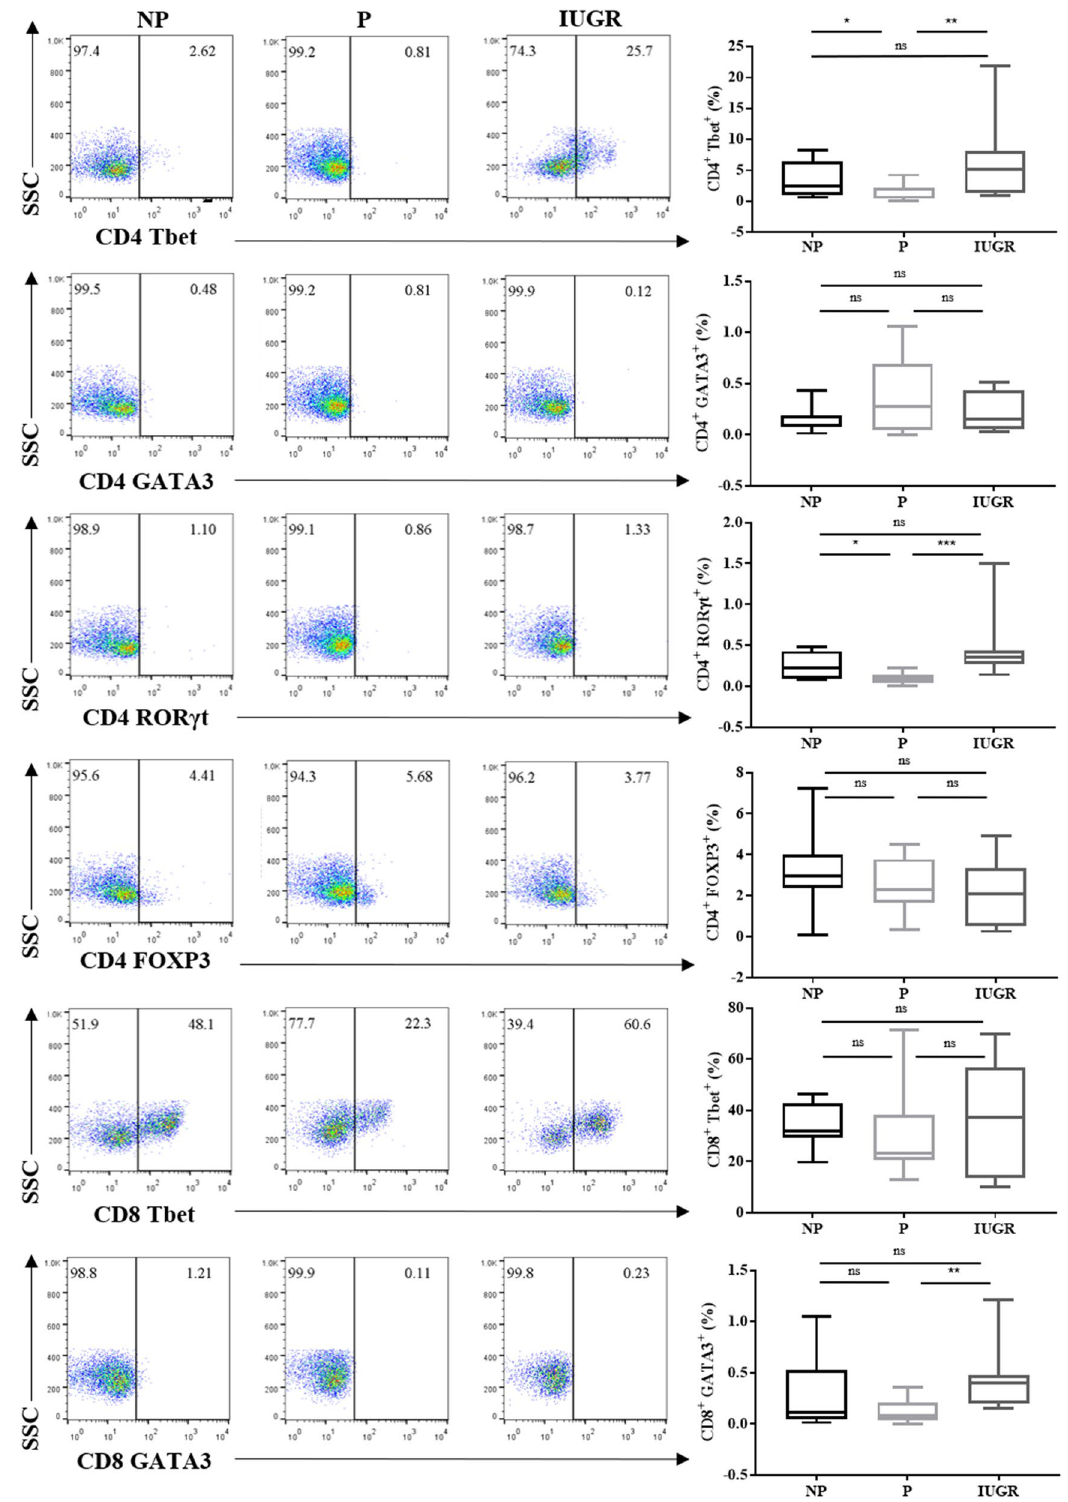
Figure 2. Tbet and RORγt is decreased in CD4 + T-cells during normal pregnancy compared IUGR. Representative flow cytometry dot plots of transcription factor expression in CD4 + Tbet (Th1), GATA3 (Th2), RORγt (Th17), FOXP3 (Treg) and CD8 + Tbet (Tc1), and CD8 + GATA3 (Tc2) T-cells from NP (n = 12), P (n = 12) and IUGR (n = 8). Box and whisker plots indicate median and IQR of T-cells expressing transcription factors. * p < 0.05, p ** < 0.01, ns = non- significant, determined by Kruskal–Wallis with Dunn’s multiple comparisons test. Flow cytometry data were analysed using the FlowJo Software Version 10 (Becton Dickinson); website: https:// www. flowjo.